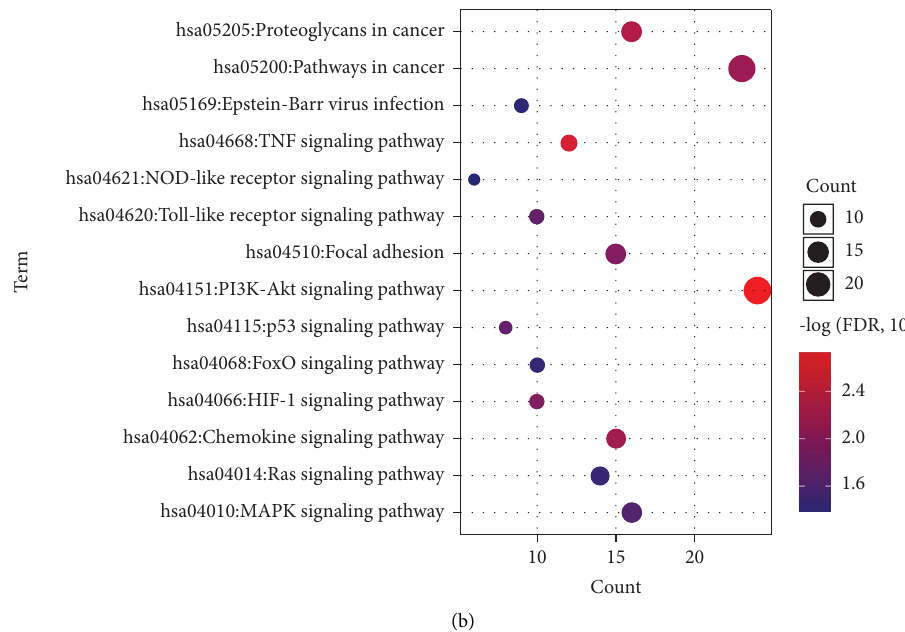
Figure 2: Functional analyses of the overlapping DMD-related DEMs. (a) Signifcantly enriched gene ontology (GO) terms of biological processes. (b) Signifcantly enriched Kyoto Encyclopedia of Genes and Genomes (KEGG) signaling pathways of the DMD-related DEMs. Te horizontal axis indicates the number of the DMD-related DEMs, and the vertical axis indicates the name of items. Te larger the dots, the greater the number of DEMs. Te darker the dot, the more signifcant the enrichment of